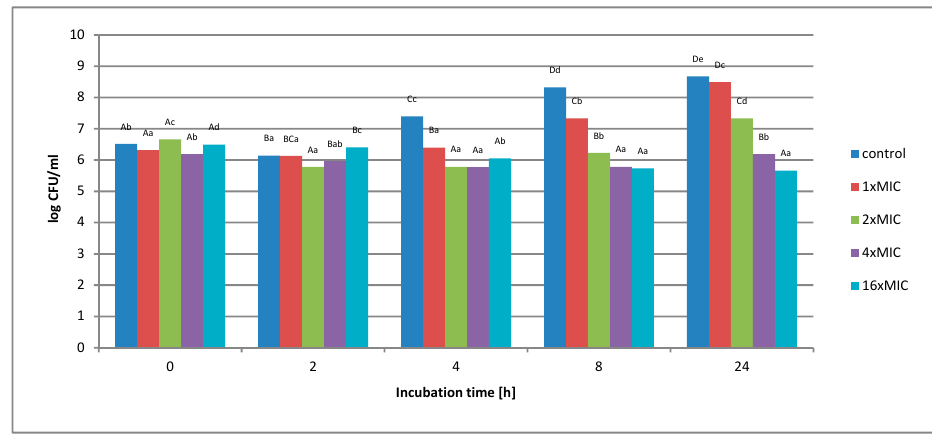
C, D—the effect of matrix type on the change in the number of bacteria at the same time of storage; a, b, c, d—the effect of incubation time on changing the number of bacteria.